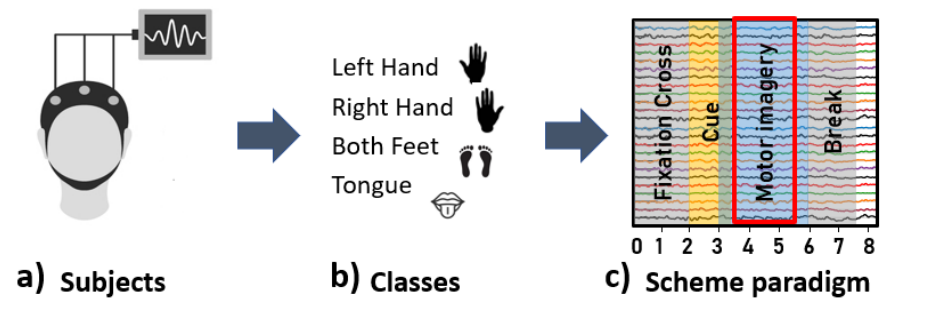
Figure 1. Time and scheme